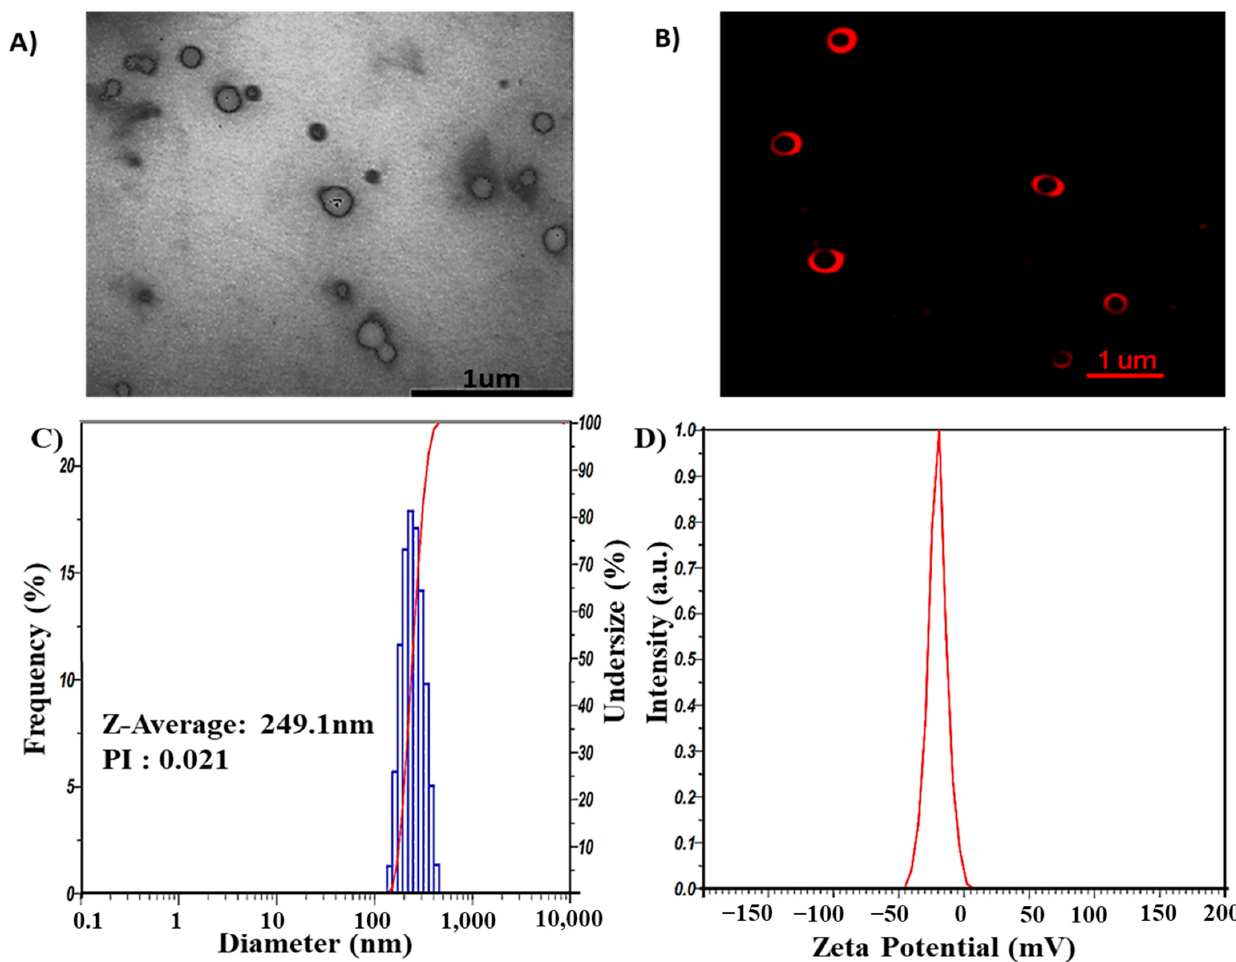
Figure 2. Morphology of GL nano-lipids according to TEM image ( A ) and confocal microscopy image labeled with DiL C18 ( B ). Size distribution ( C ) and ζ potential values ( D ) as obtained by DLS of GL nano-lipids at 25 °C.